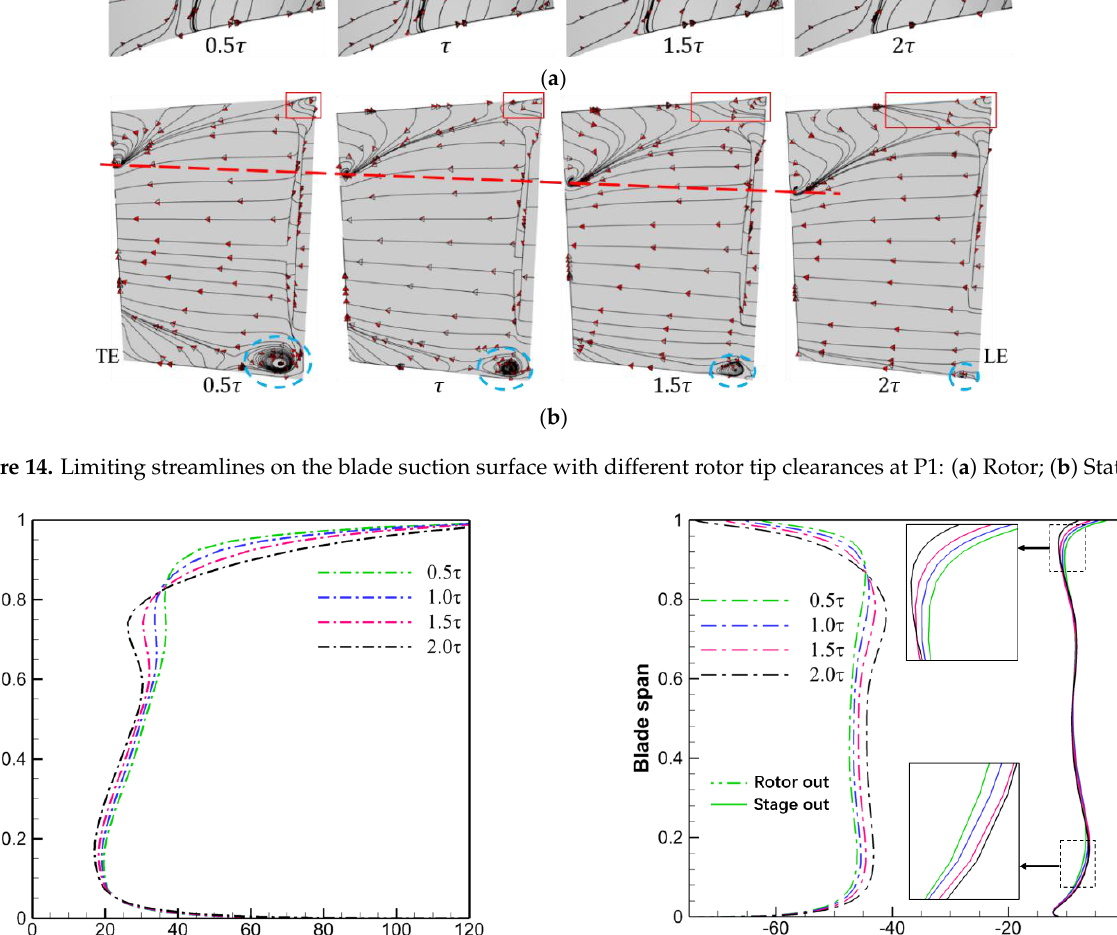
Energies 2021 , 14 , x FOR PEER REVIEW 13 of 20